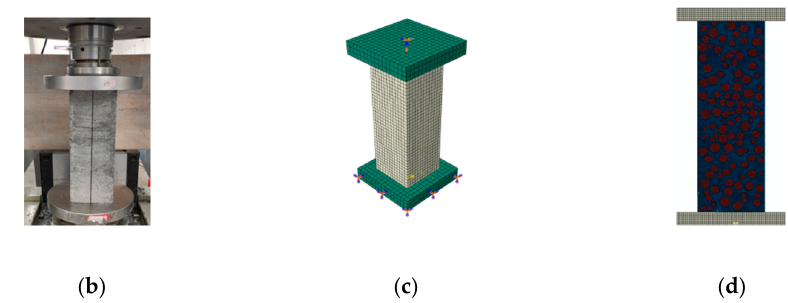
Figure 5. Axial compressive strength and elastic modulus test: ( a ) schematic design, ( b ) physical diagram, ( c ) inclusion model, and ( d ) 2D random model.